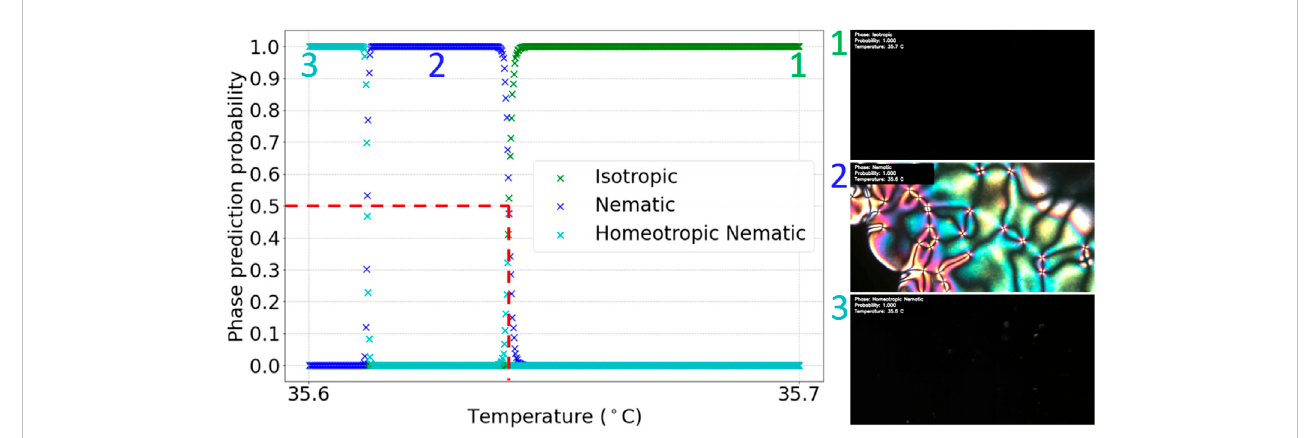
FIGURE 4 Graph of phase prediction probability against temperature for a labelled I-N transition test video. The vertical dashed line shows the identi fi ed transition